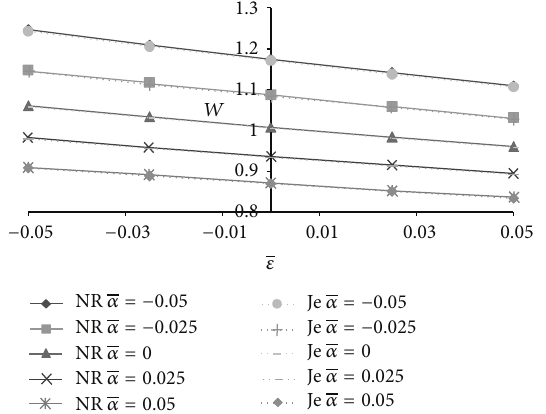
Figure 12: Variation of load carrying capacity with respect to 𝜀 and 𝛼